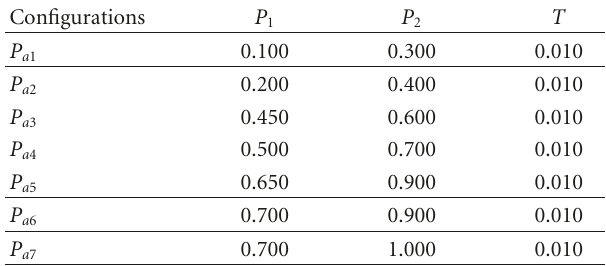
Table 1: The parameter settings for the five di ff erent AAQM